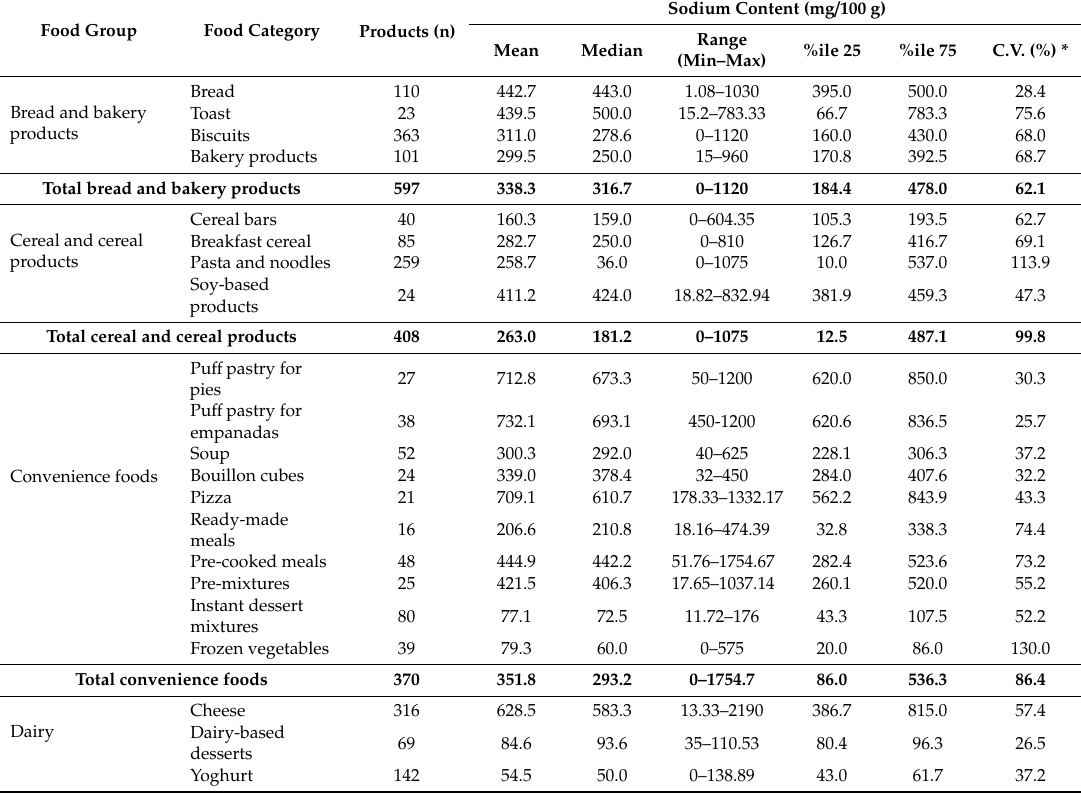
Table 1. Sodium content of processed foods in Argentina by food group and category (n = 3674). Food